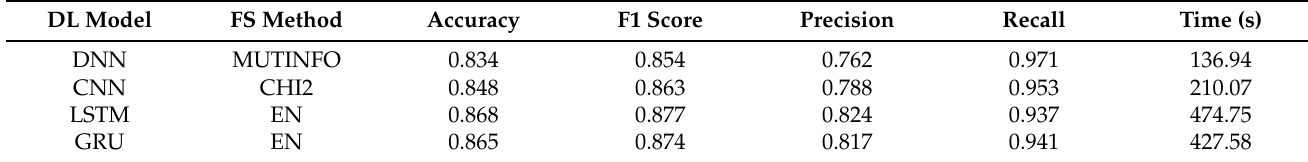
Table 10. Individual deep learning model best performance